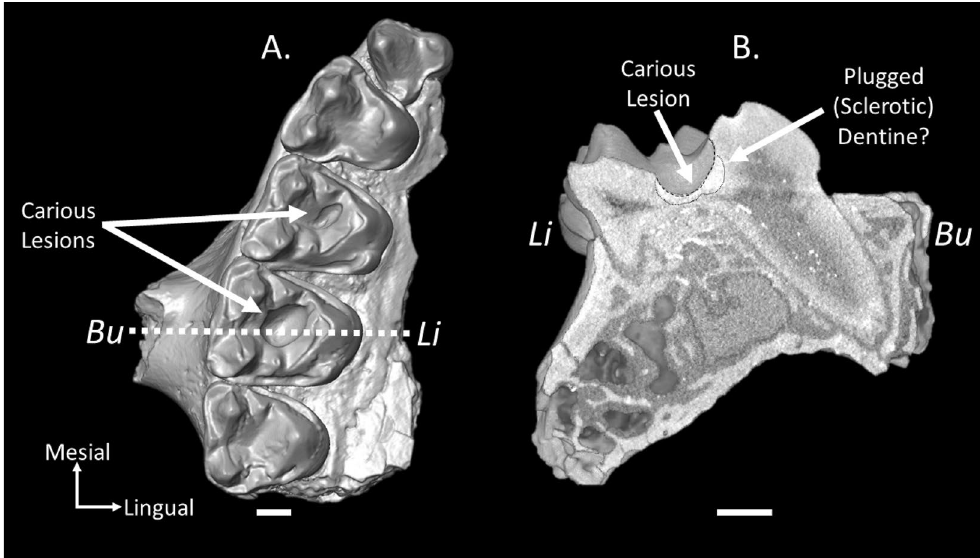
Figure 1. Micro-CT reconstruction of ( A ) the right upper jaw fragment (P 3 –M 3 ) of M. latidens (USGS